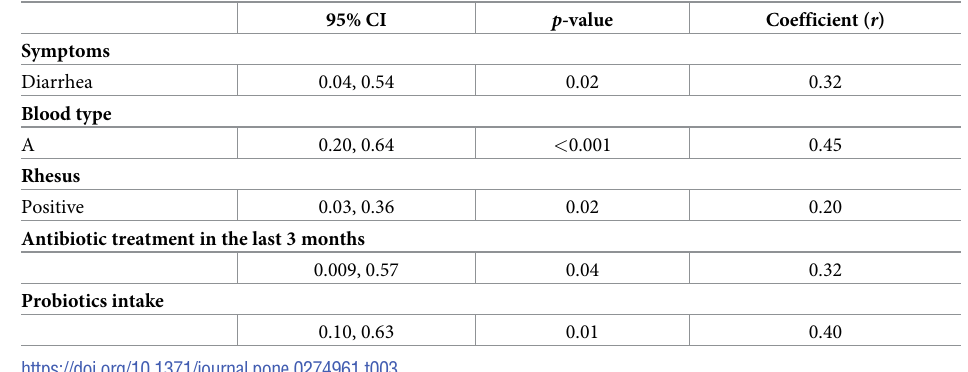
Table 3. Factors associated with changes in viral load in nasopharyngeal